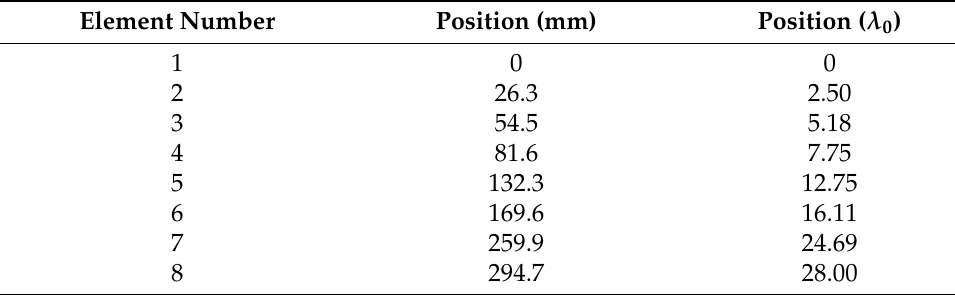
Table 3. Positions of the antenna elements of the irregular